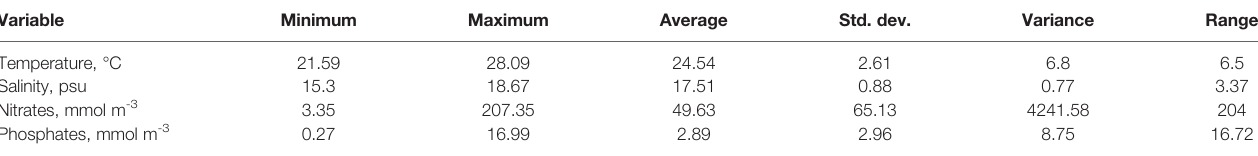
TABLE 3 | Summary of the statistic of the environmental variables in the study area. Variable Minimum Maximum Average Std. dev. Variance Range Temperature,